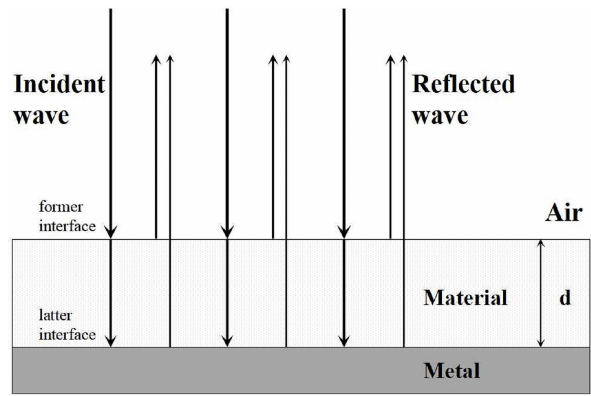
Figure 1: Schematic of a single absorber under microwave irradia-